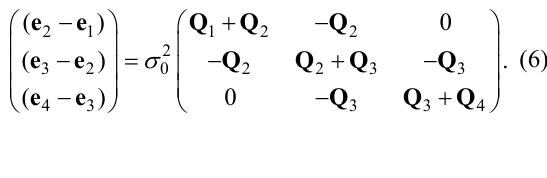
Table 2. The main statistics of the kinematic adjustment of the common levelling network, grouped by the adjustment model and levelling combinations: degrees of freedom df , variances of unit weight 2 0 S and the corresponding p -values of the null-hypothesis 2 comparison of variances of unit weight 2 0 S and mean standard errors  of the adjusted vertical velocity differences from the ‘heights included’ and ‘heights eliminated’ models, with p -values for the